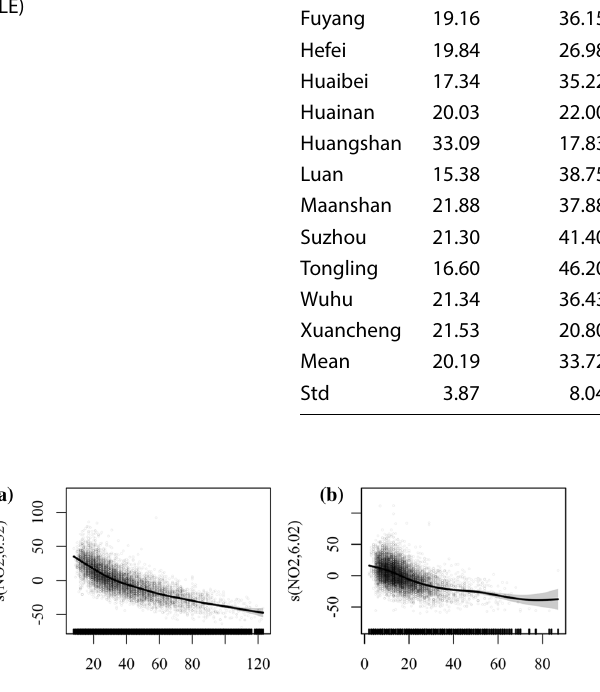
Table 2 Relative importance of variables in 16 cities, including temperature (T), relative humidity (RH), wind speed (WS), wind direction (WD), hour of day (HOD), concentration of NO and electricity consumption (ELE)